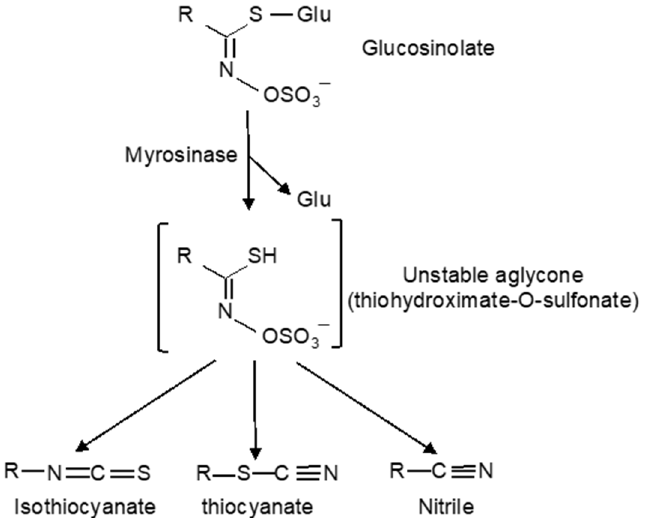
Figure 1. The glucosinolate–myrosinase defense system. Glucosinolates are hydrolyzed by myrosi- nases upon tissue damage to generate unstable aglycones, which can rearrange to produce chemically active isothiocyanates, thiocyanates, and nitriles.